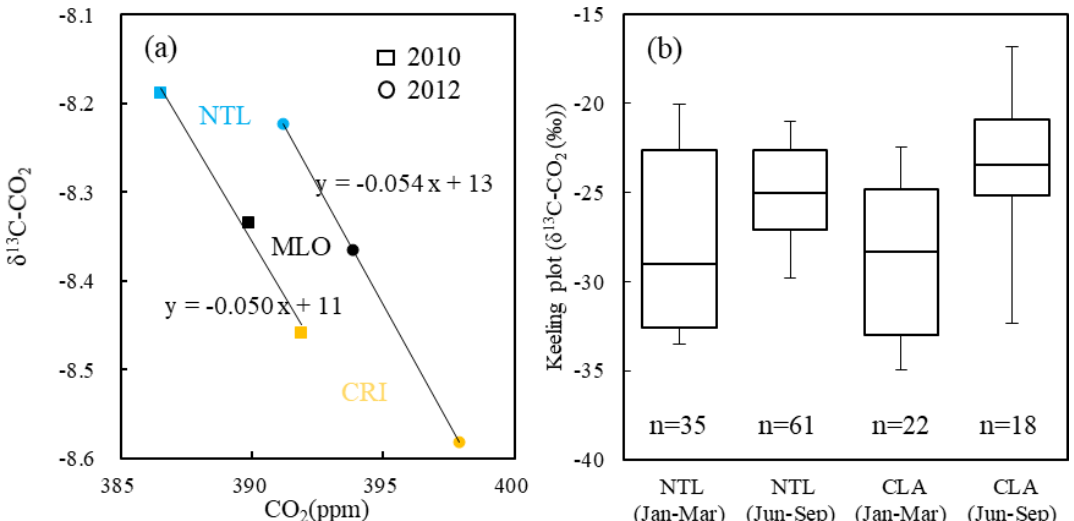
Figure 7. (a) Relationship between the annual values of the CO 2 mole fraction and isotopic ratio of δ 13 C-CO 2 at NTL, CRI, and MLO in 2010 and 2012 and (b) the intercept values of the Keeling plot of NTL and CLA in January–March and